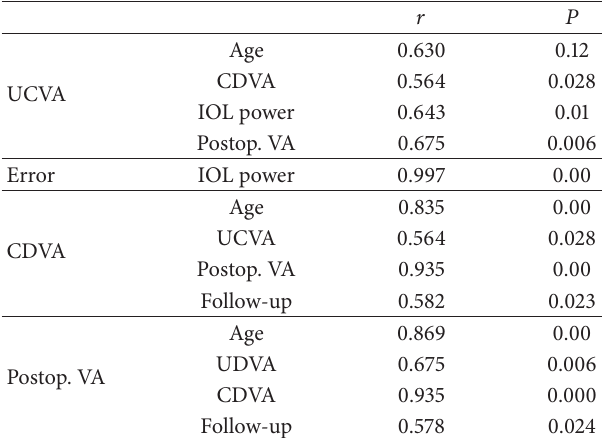
Table 2: Patients demographic data.